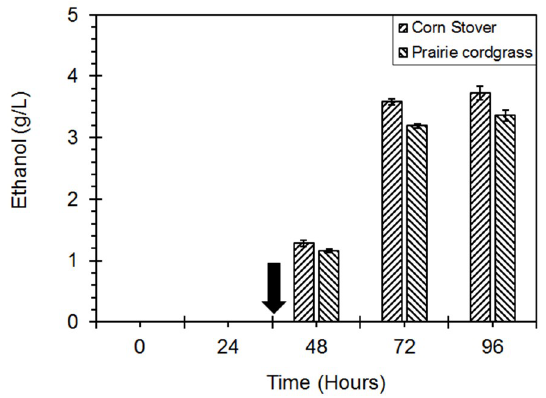
Figure 12. Ethanol production with co‐culture of Geobacillus sp. strain DUSELR13, and Geobacillus thermoglucosidasius . The black arrow represents the point of addition of Geobacillus thermoglucosidasius. The values are mean of triplicate experiments and the error bars represent ± SD of the means with n = 3. Table 5. Mass balance for ethanol production using PCG and